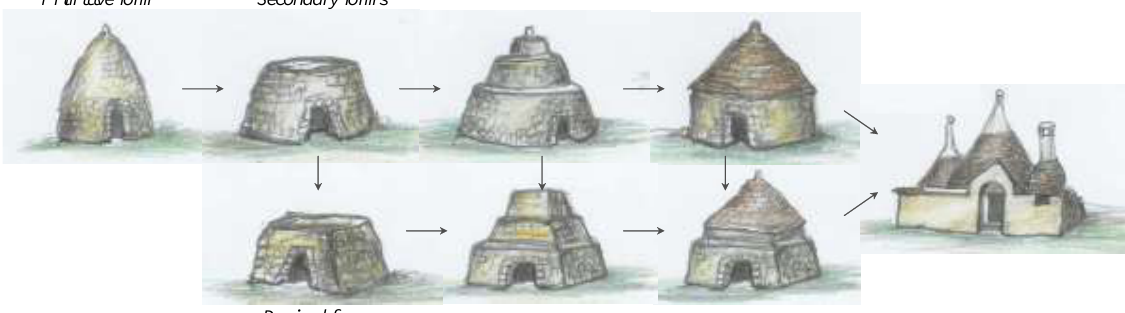
Figure 2. Evolution of the trullo over thousands of years.